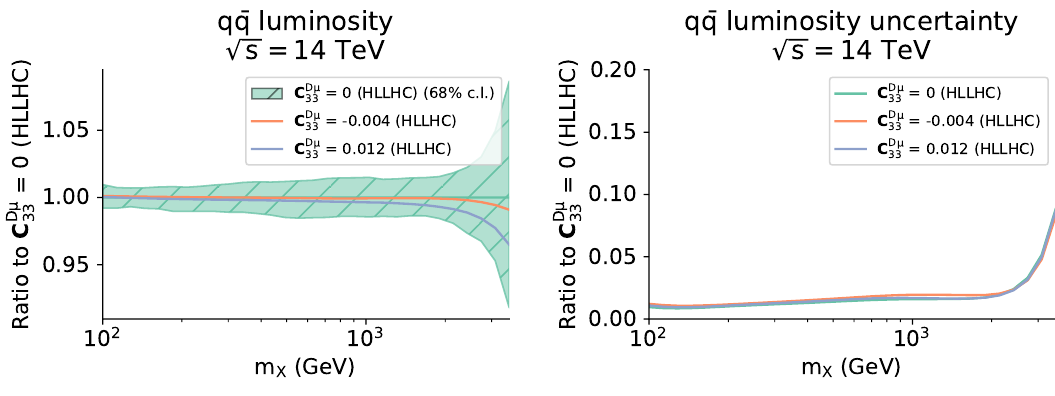
Figure 19 . Same as figure 16 now in the case of the simultaneous fits of the PDFs and the C Dµ EFT parameter taking into account HL-LHC